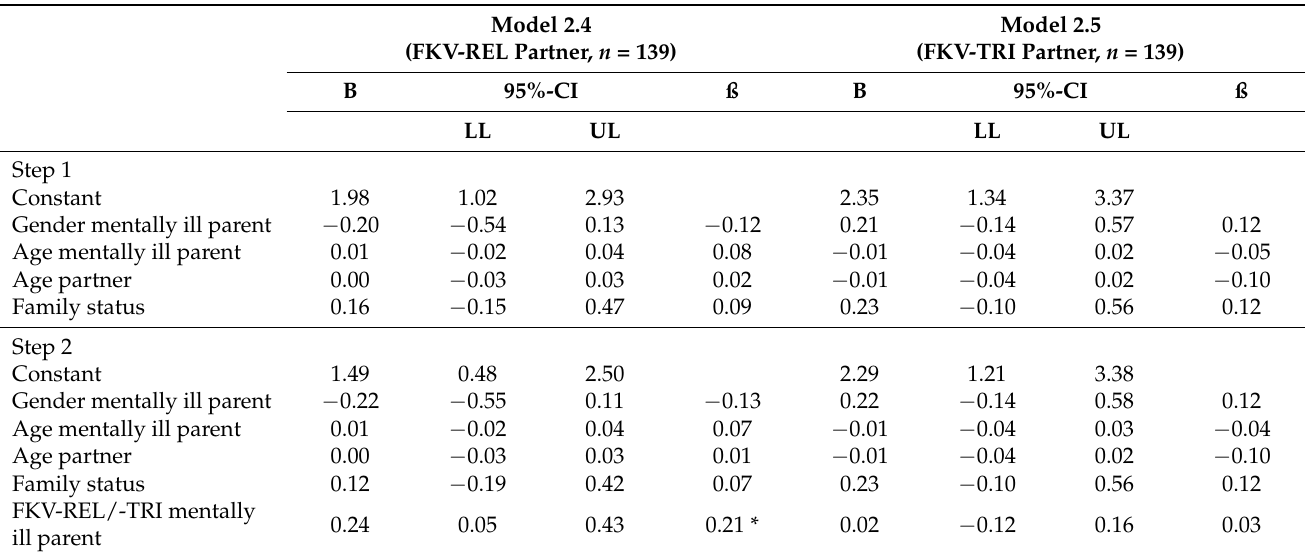
Table 6. Hierarchical regression analyses predicting partners’ symptom coping strategies using FKV-REL and FKV-TRI